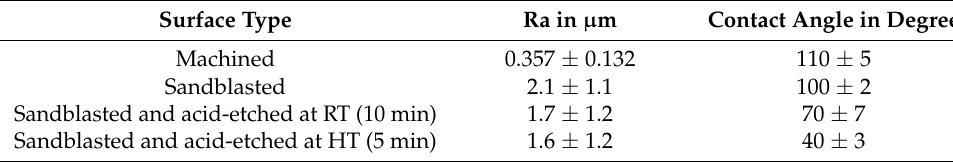
Table 2. Ra Value of the different experimental surfaces of the dental